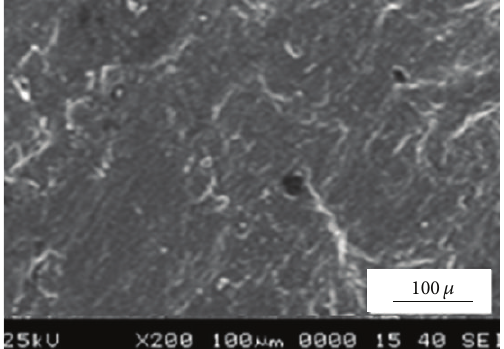
Figure 12: SEM micrograph of the worn surface of the Al-7.5wt.% Gr composite at a normal load of 49N with 1m/s sliding velocity.